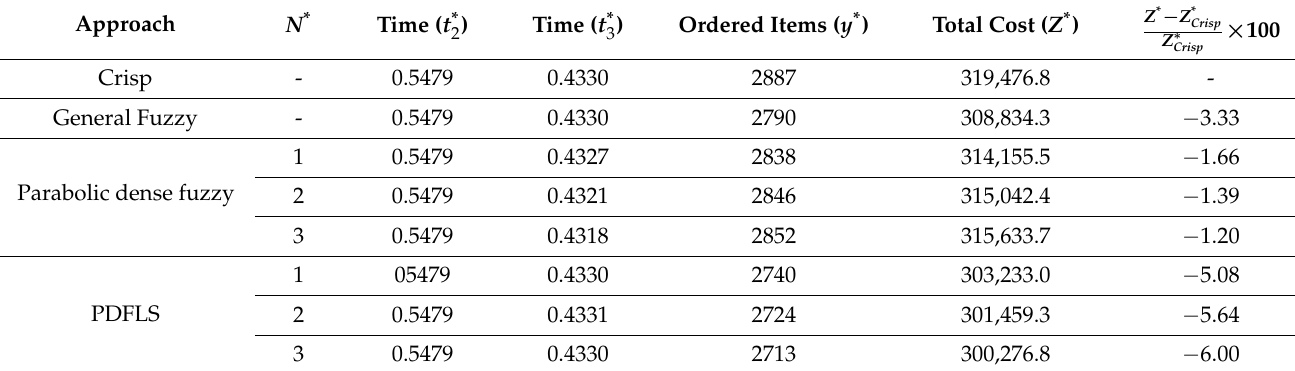
Table 2. Numerical result of the proposed model.